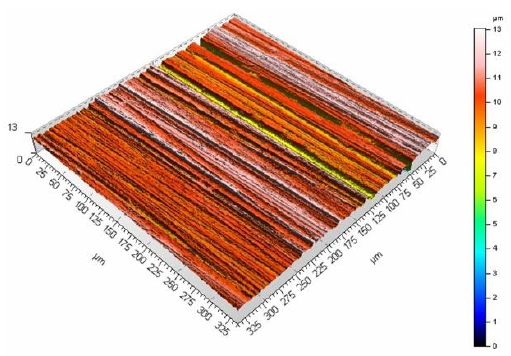
Figure 14. The surface morphology of a surface treated with emery paper no. 240 (mean roughness: Sa = 0.79 μ m).